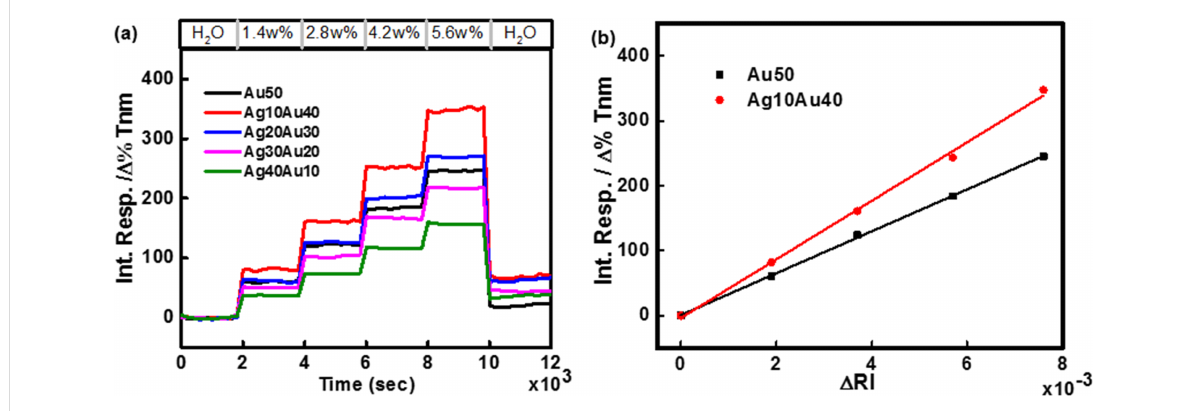
Figure 3: (a) Integrated multispectral response of five full-3D PCs with different metal composition to injections of increasing concentration of aqueous PEG solutions (from 1.4 to 5.6 wt %). Transmittance changes as a function of time were collected over a wavelength range of 355–1000 nm. (b) Linear change in the average integrated response with refractive index change on Au50 and Ag10Au40 full-3D PCs.